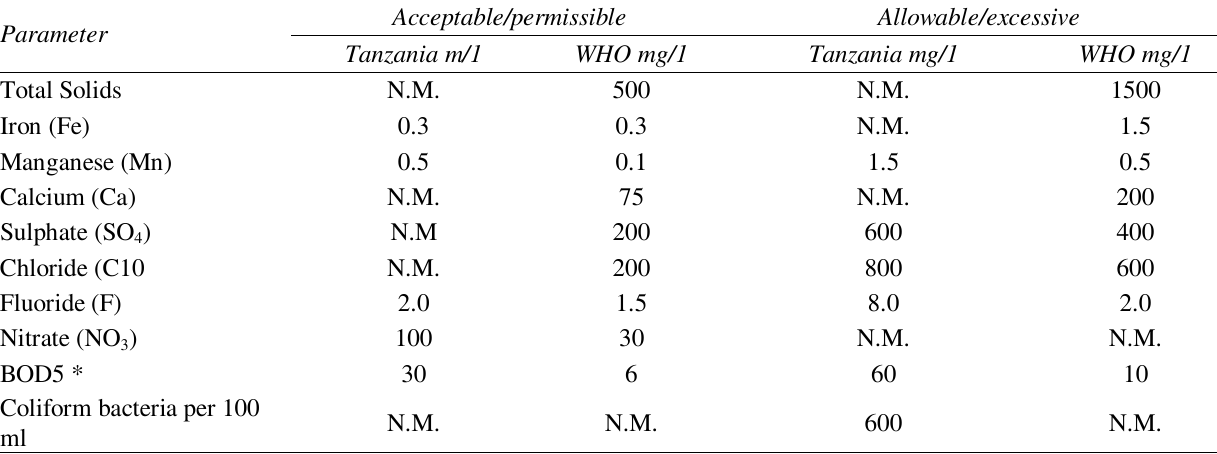
Table 6: Key Water Quality Parameters Levels